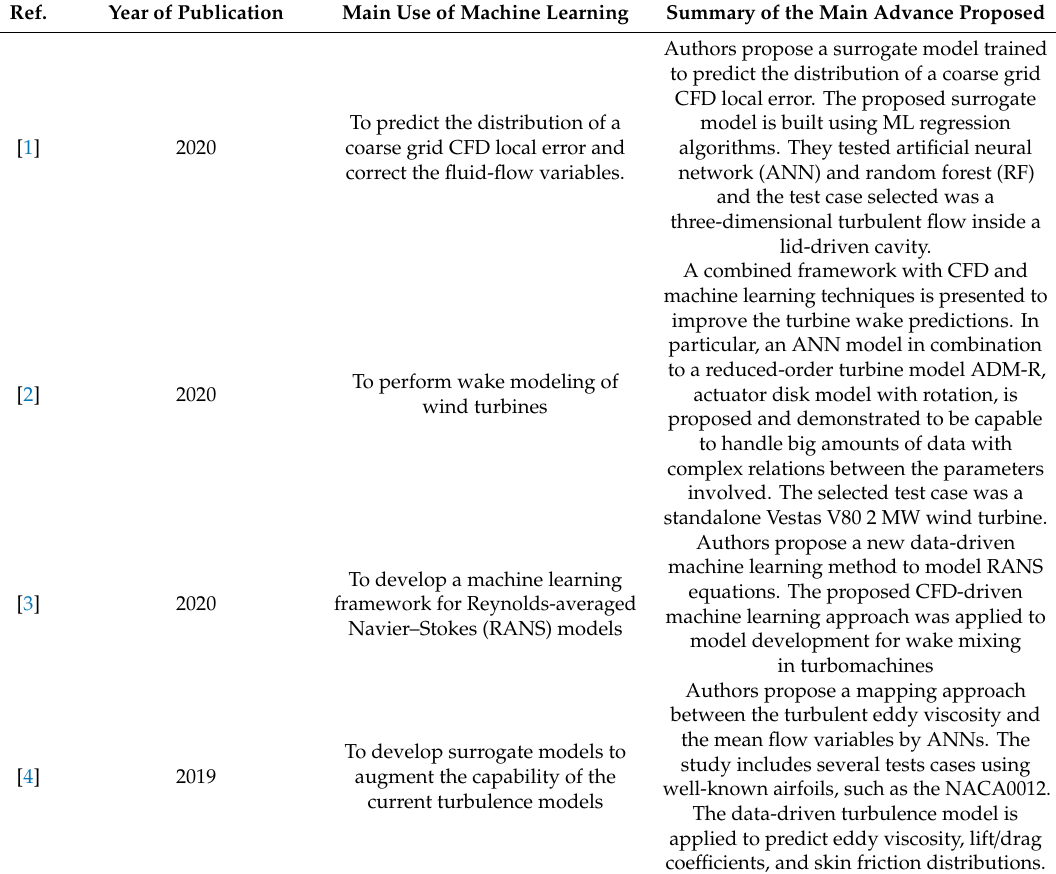
Table 1. Summary of the recent state-of-the-art studies in the scientific literature.